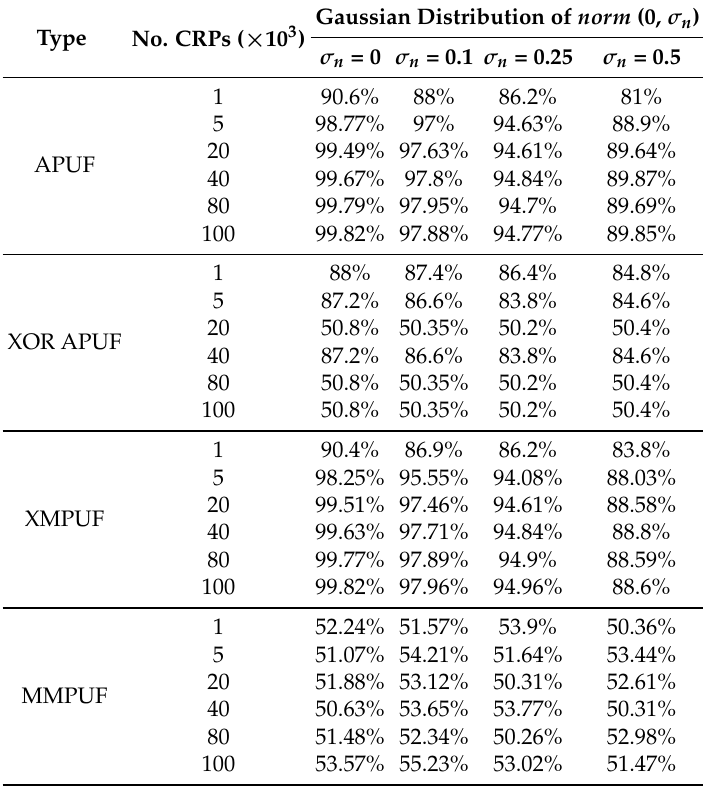
Figure 8. The prediction rates of LR attacks on 64-bit XMPUF and MMPUF designs affected by noise. Table 1. Prediction Rates Affected by